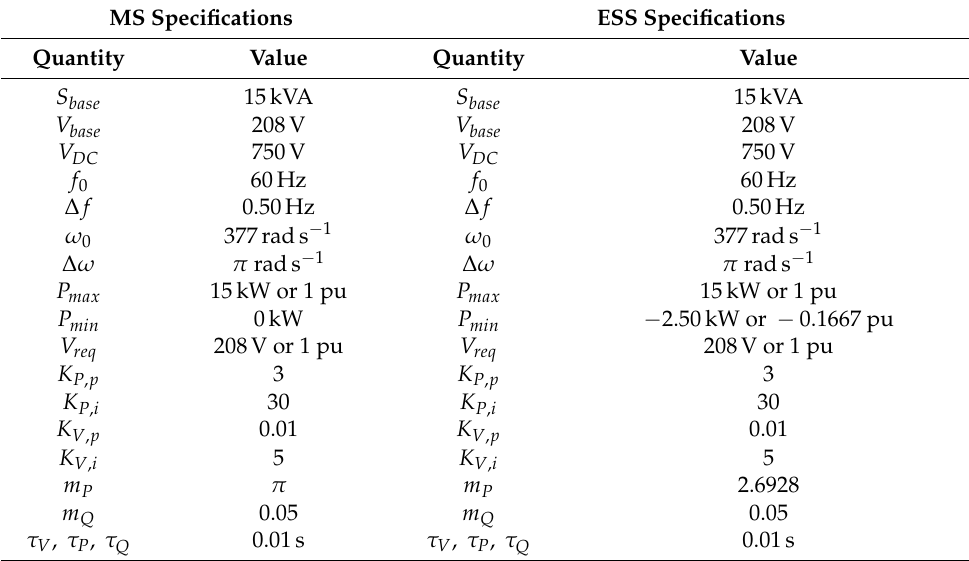
Table A3. Inverter-based DGUs (i.e., ESS and MS) specifications.